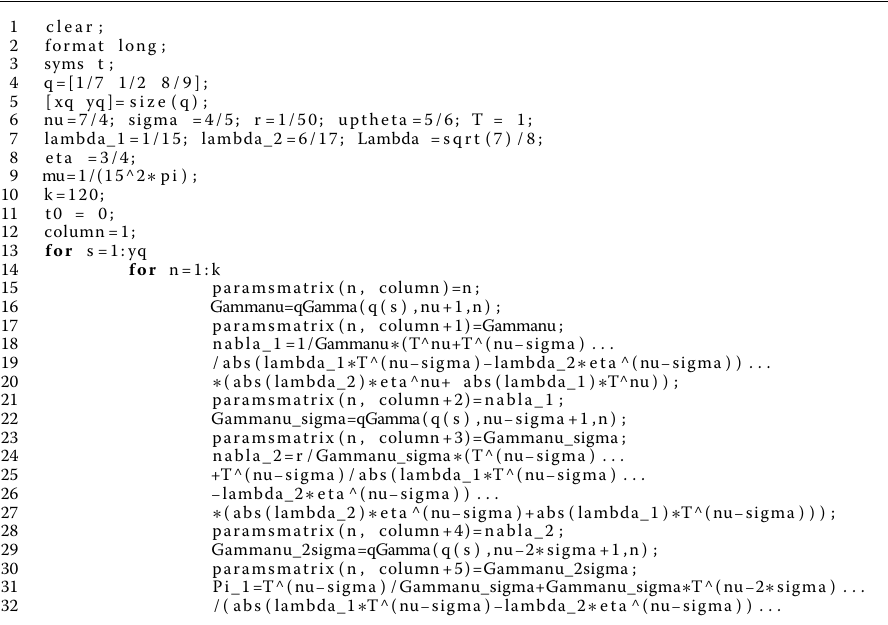
˘ (cid:21) in Example